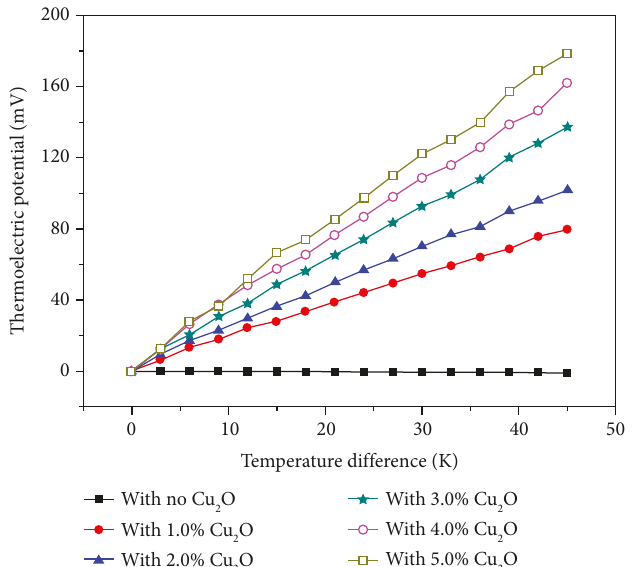
Figure 7: Relationship between the temperature difference and thermoelectric potential of cement composites with added nanostructured Cu 2 O powder.